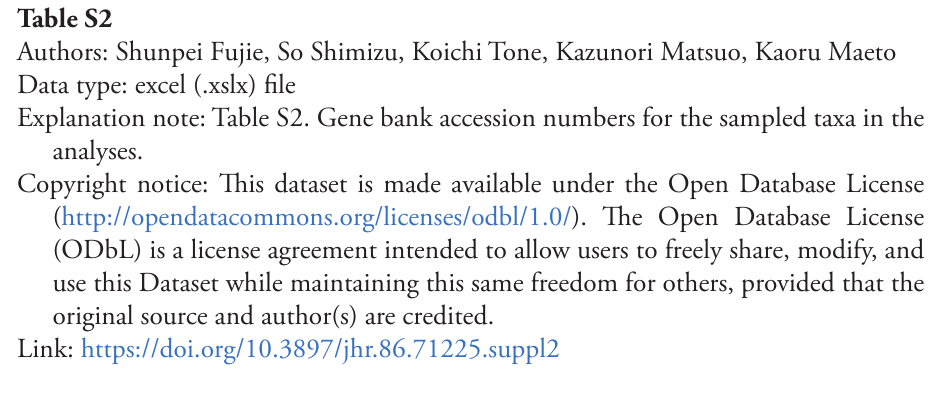
Explanation note: Table S2. Gene bank accession numbers for the sampled taxa in the